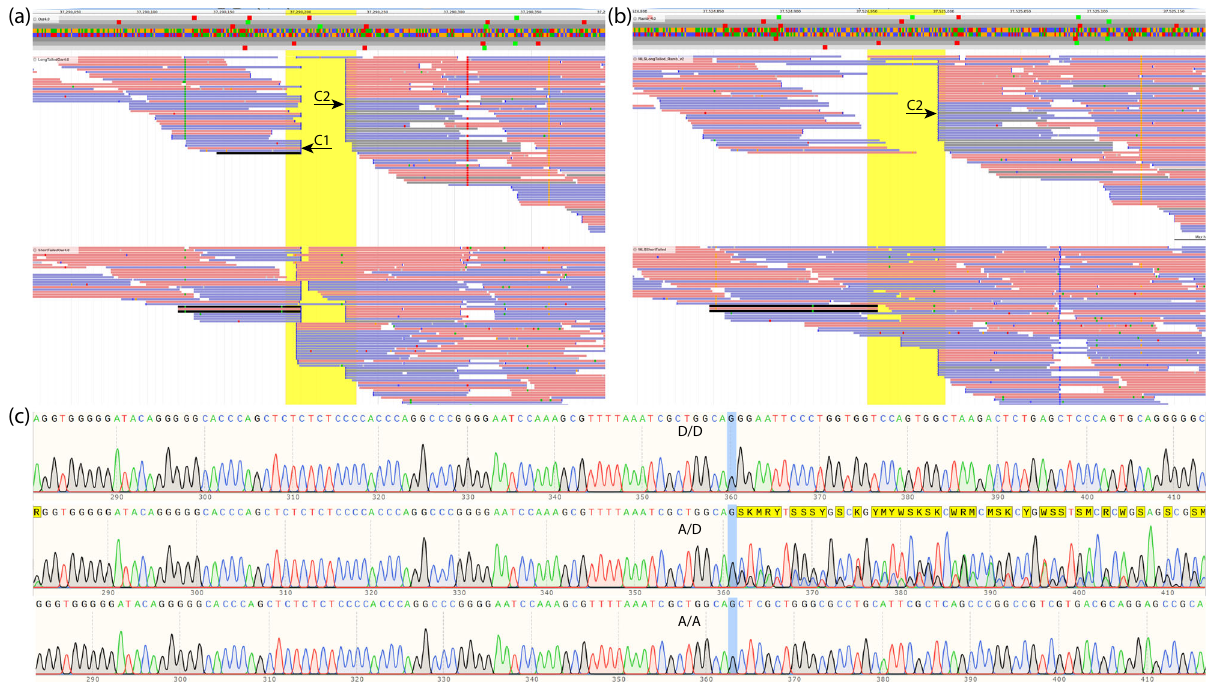
Fig. 2 Alignment of the initial amino acid sequence of HOXB13 in different mammals. Positions of interest are highlighted. The asterisks present unique, the colons high similar and the single point moderate similar amino acids in every species on the respective position. To highlight the area of interest we used Clustal Omega 90,91 DA derived allele, AA ancestral allele.